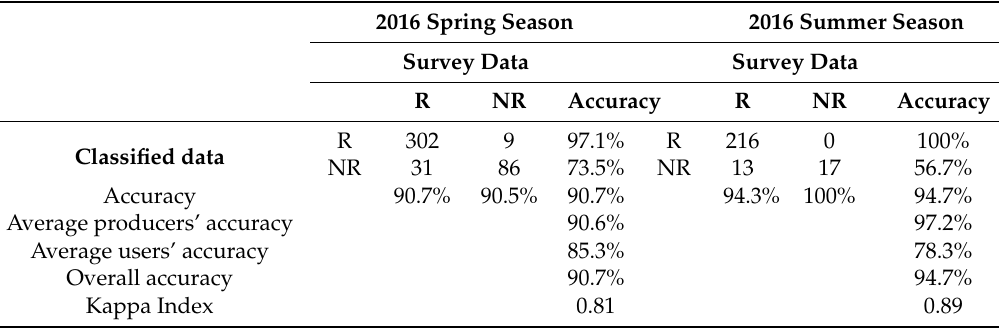
Table 2. Accuracy assessment of rice area derived from SAR Sentinel-1 used in this study for the 2016 spring and summer seasons in the Red River Delta of Vietnam. Survey and classified data represent the number of points identified as rice (R) or non-rice